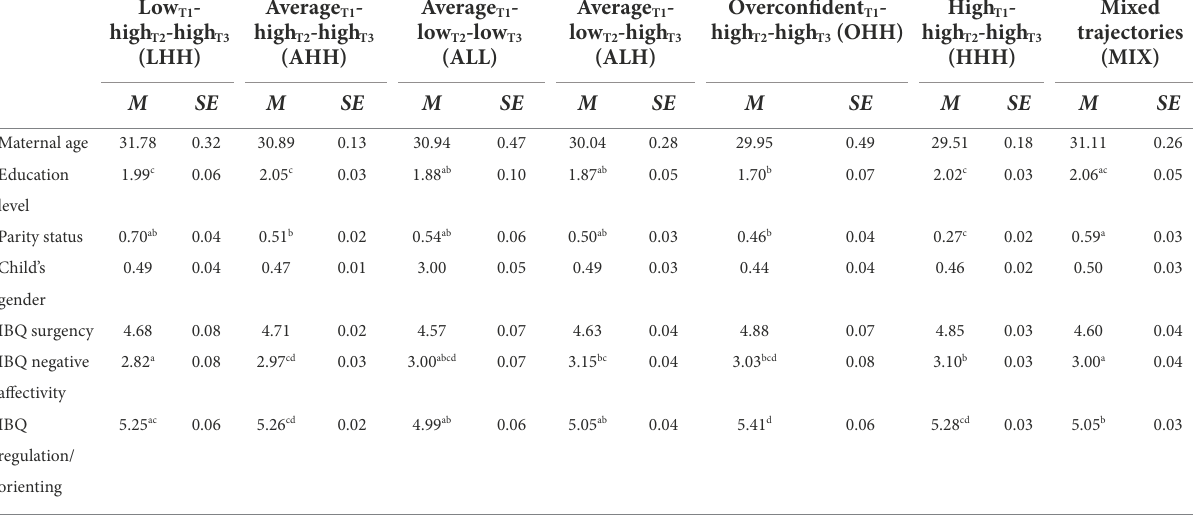
TABLE 5 Predictors (with mean estimates) of membership in the maternal PRF